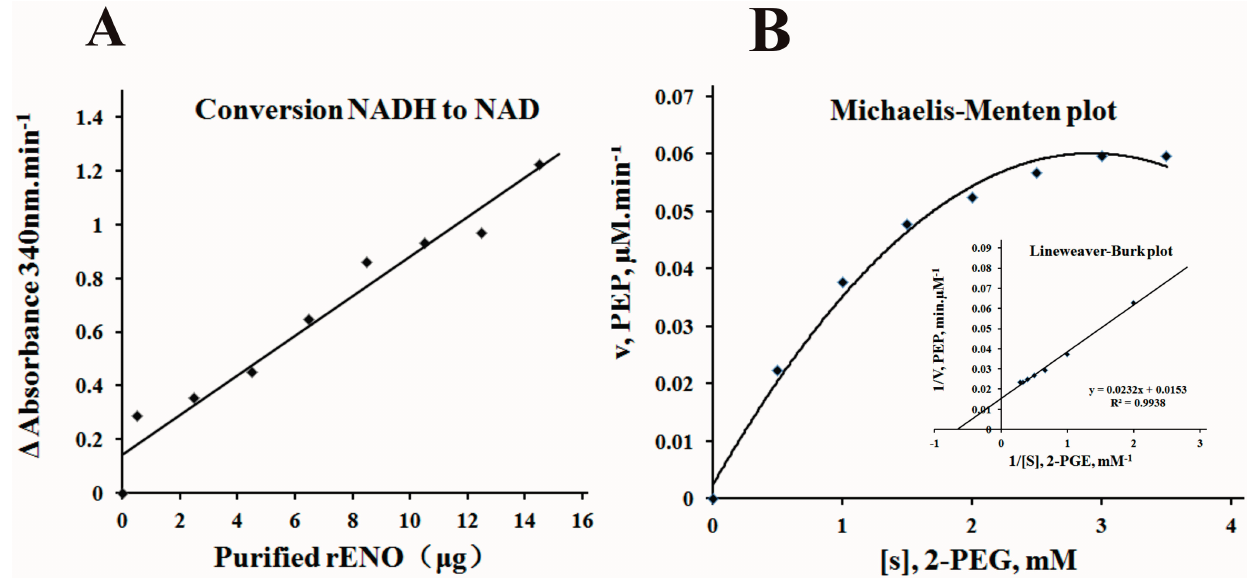
Figure 4. α -enolase activity and enzyme kinetics analysis. ( A ) The coupled-enzyme assay of the rENO was detected by the catalytic rate of conversion of NADH to NAD min − 1 in the presence of lactate dehydrogenase, ADP, and pyruvate kinase were measured as A 340 nm·min − 1 ; ( B ) Enzyme kinetics of rENO were determined by measuring the rate of conversion of 2-PGE to PEP in the presence of various concentrations of substrate (2-PGE; 0.5–3.5 mM) and 5 μ g of the purified rENO and monitored the changes of absorbance at 240 nm. Data was plotted by the method of Michaelis–Menten (inset) and V max and K m were calculated from double reciprocal